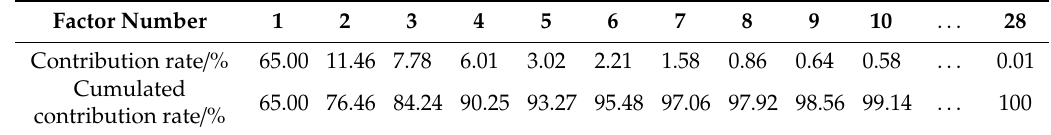
Table 1. Contribution rate of principal component